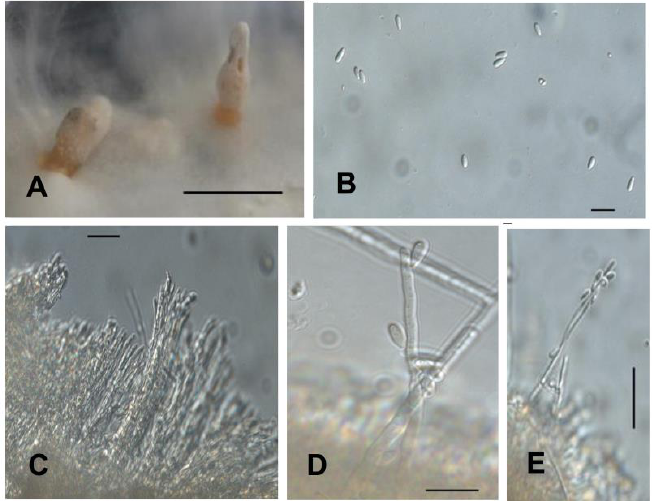
Figure 7. Isolated Xylaria sp.3. ( A ). Stromata obtained in culture on MS medium; ( B – E ). Differential interference contrast microscopy (DIC) (40×); ( B ). Conidiospore; ( C ). Palisade of mature conidiophores; ( D ). Mature conidiophores; ( E ). Conidia produced at the tip of a conidiophore.—Scale bars ( A ) = 1 mm, ( B – E ) = 10 µm.